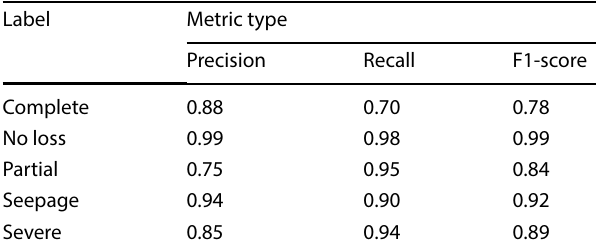
Table 9 Performance measurements achieved by the CNN model for the testing subset of data records Label